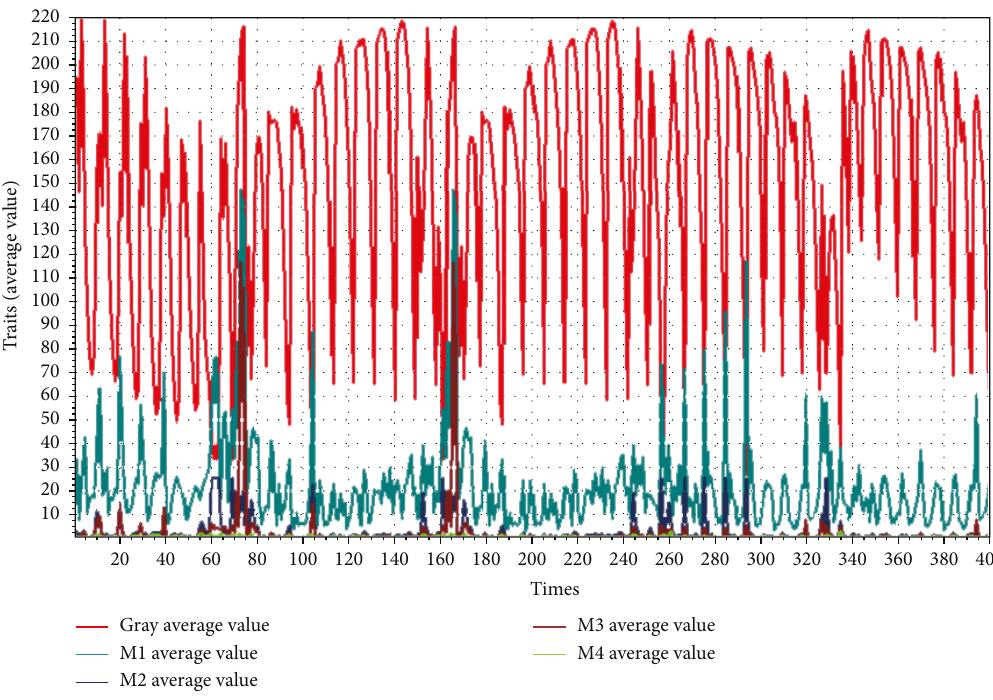
Figure 11: The correlation between the input feature